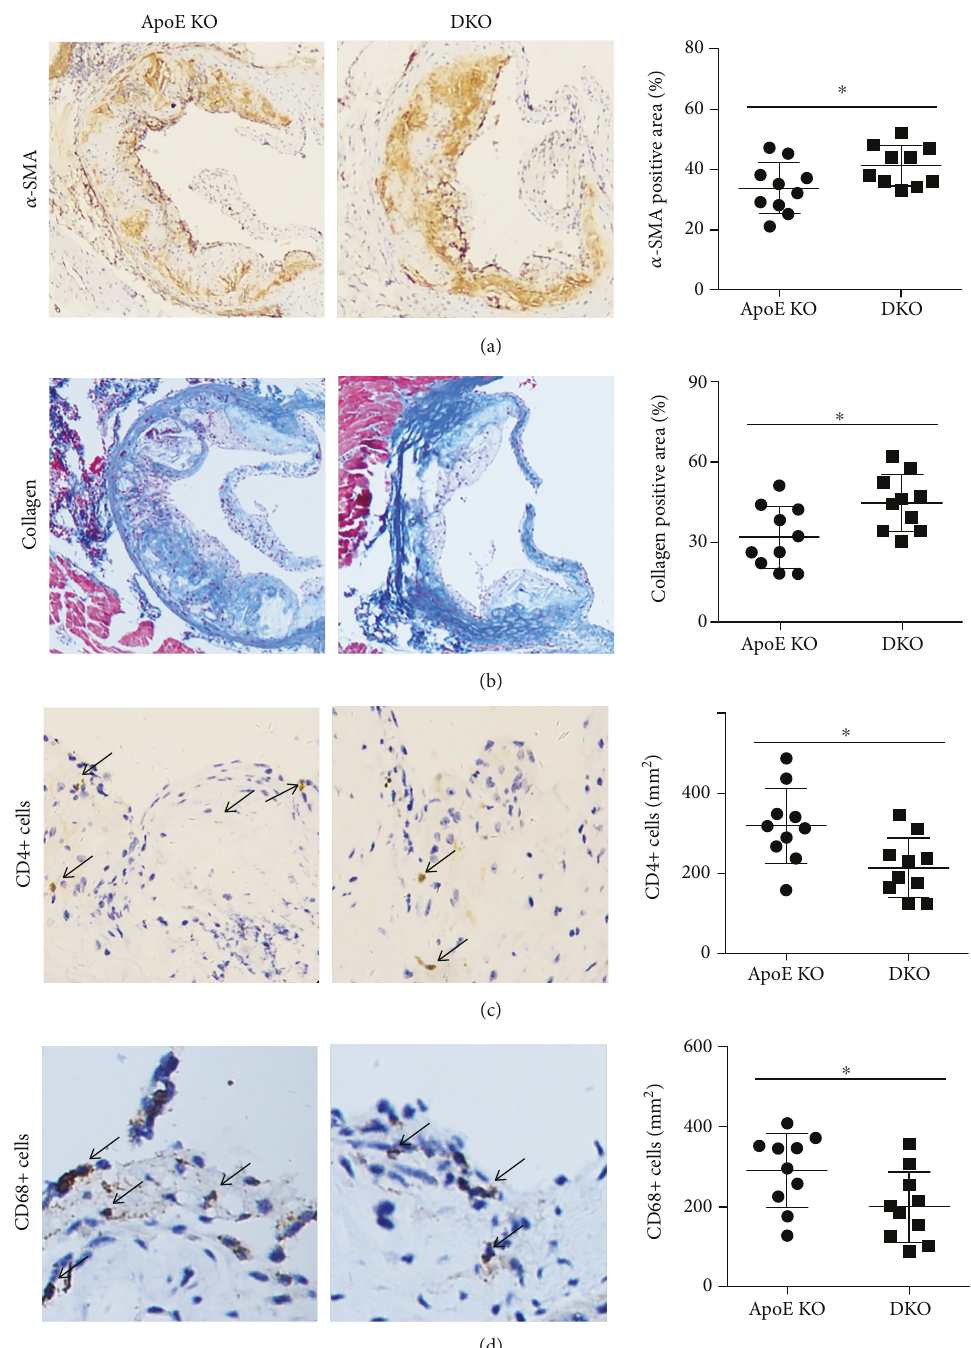
Figure 2: E ff ect of IL-12p35 de fi ciency on the stability of atherosclerotic plaque in the aortic sections of ApoE-/- mice. The aortic roots of (a) α -SMA-positive area (20x), (b) collagen-positive area (20x), (c) CD4+ T lymphocyte (40x), and (d) macrophages (40x) were measured in the two groups. ApoE KO=ApoE-/-; DKO=ApoE-/- IL-12p35-/-; N = 10 for each group. ∗ P < 0 05